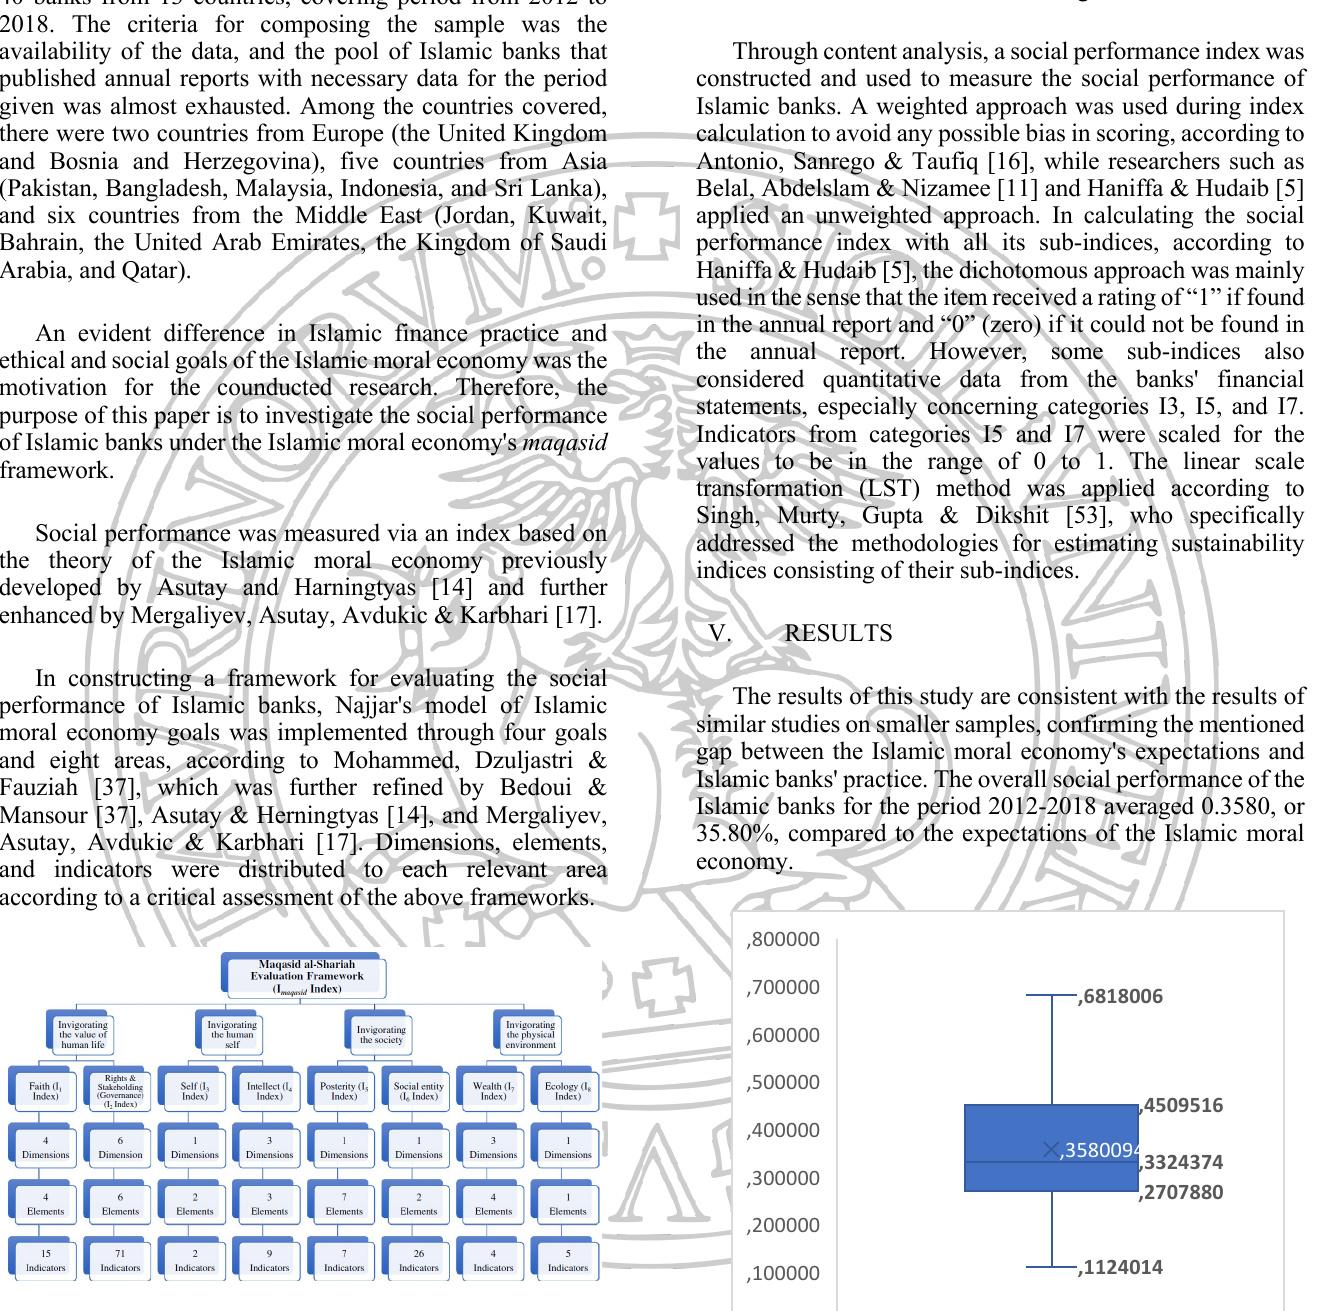
Figure 2. Islamic social performance